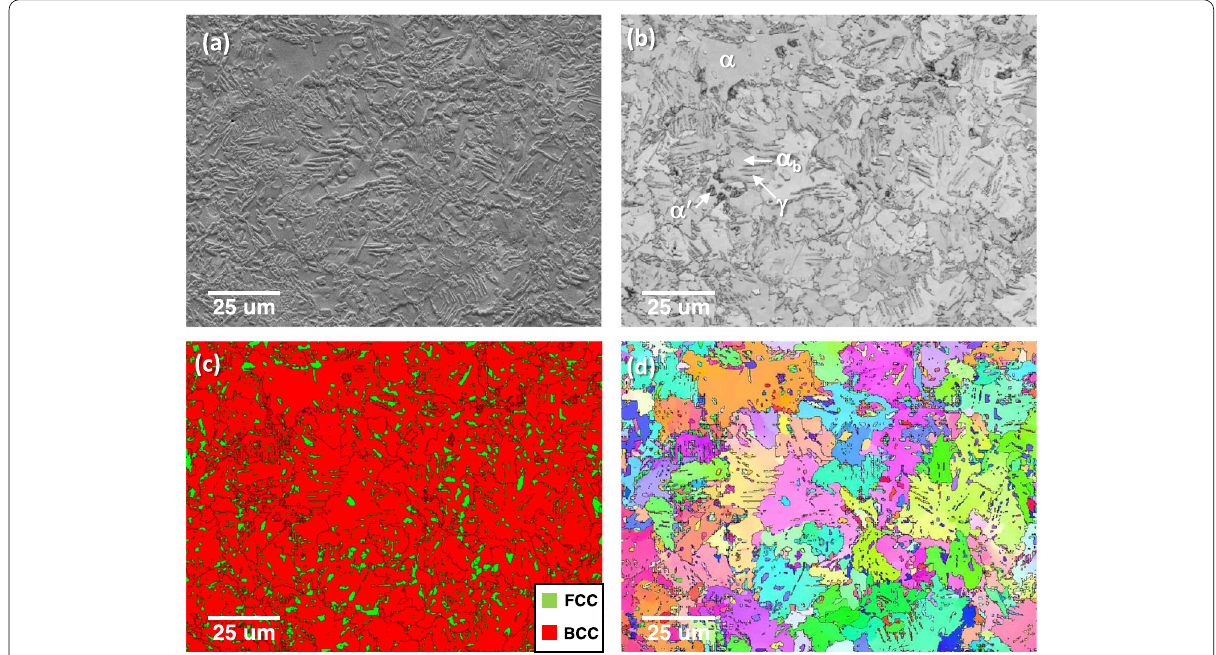
Fig. 6 Microstructure of a Fe‑1.5Mn‑1.5Si‑0.25C alloy; a secondary electron image, b Band contrast, c phase, and d inverse pole figure maps